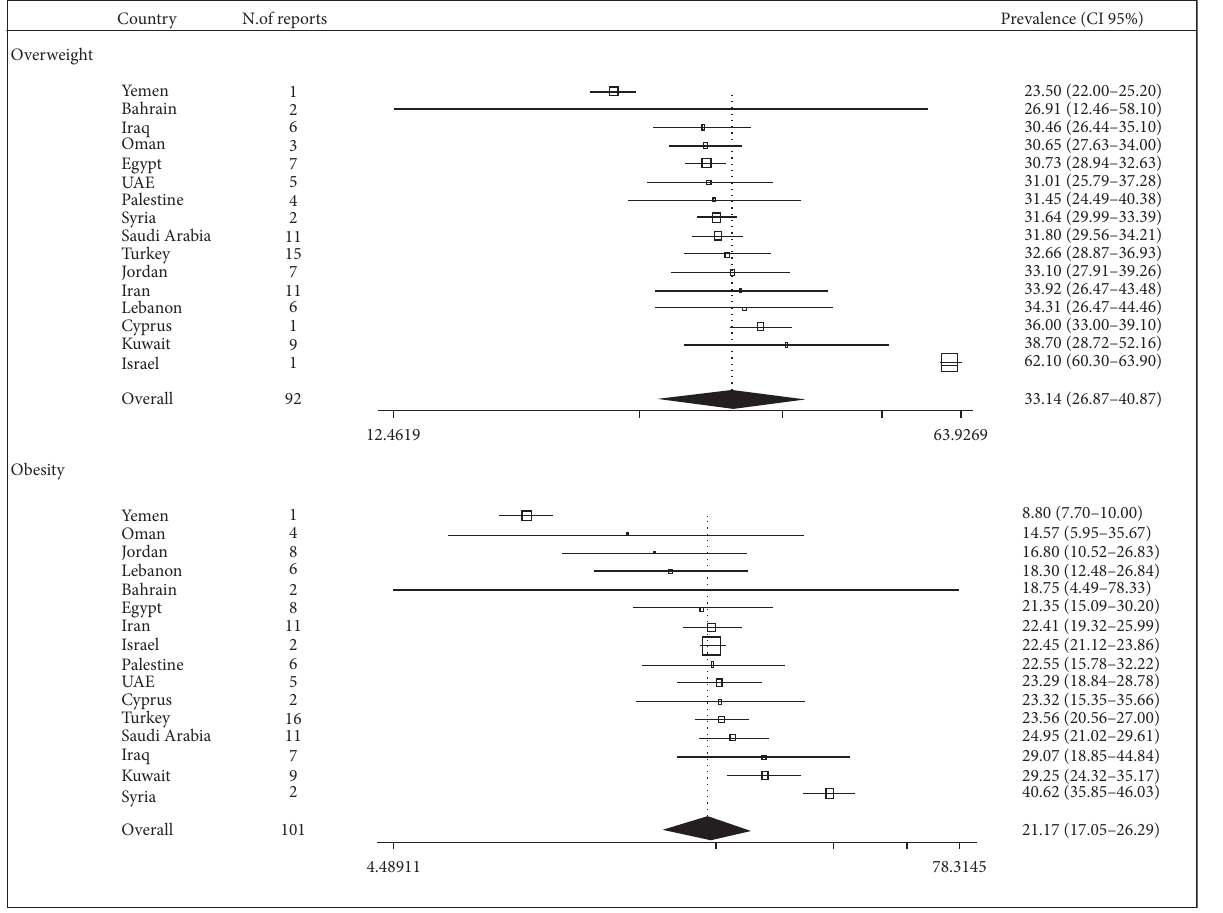
Figure 2: Overall prevalence of overweight and obesity in Middle East